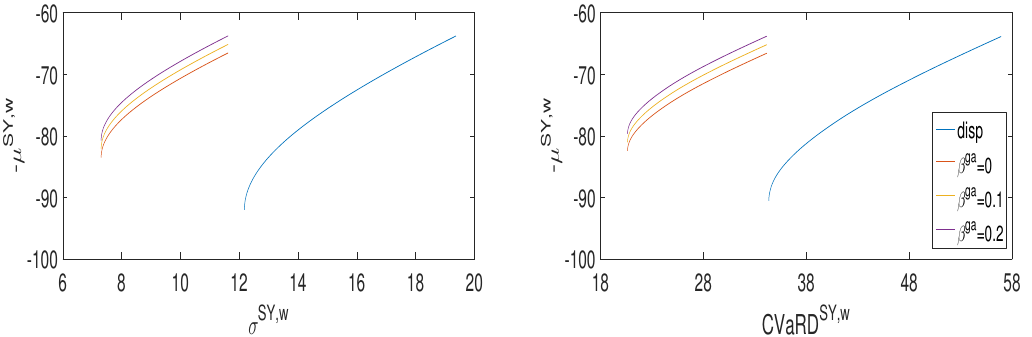
Figure 3. Efficient system portfolio frontiers in the σ ca = 0.2 scenario. Each graph plots 3 system portfolio frontiers (for β ga = 0, 0.1, 0.2) and the dispatchable system frontier (disp). The wind penetration is ¯ w wi = 40%. Left panel: The ( − µ SY,w , σ SY,w ) plane. Right panel: The ( − µ SY,w ,CVaRD SY,w ) plane. The dispatchable case is the rightmost